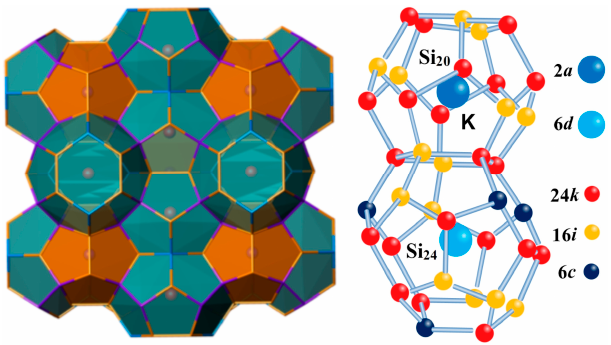
Figure 1. The sketch map of ball and stick representation of the type I clathrate K 8 Si 46 with an illustration of Wyckoff sites of the structure.